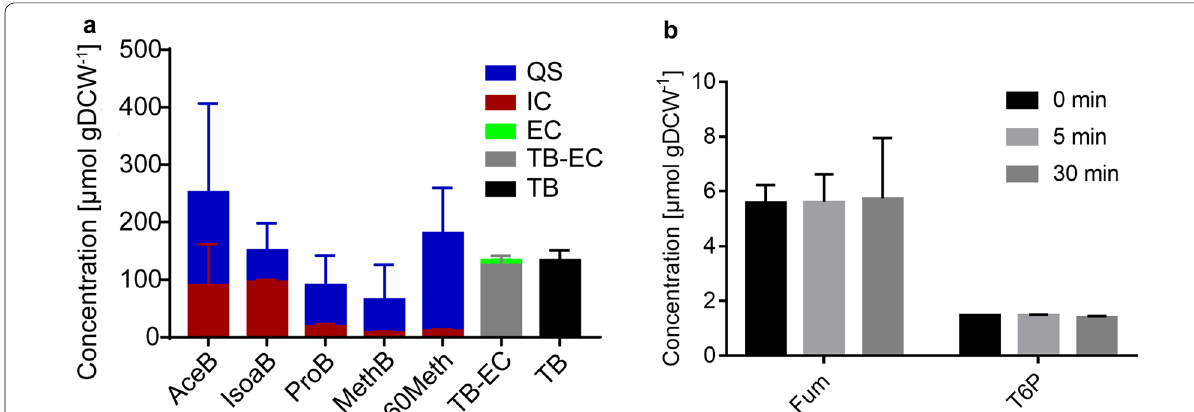
Fig. 5 a Full mass balances of all determinable metabolites. Meth60: 60% methanol at 30 °C; AceB: acetone; ProB: propanol; IsoaB: isoamylol; − MethB: methanol with base solution 5:1 (v/v) at 30 °C, respectively. The base solution consisted of acetone: ethanol 1:1 (mol/mol). QS: − = quenching supernatant; IC: intracellular; TB: total broth; and EC: extracellular. TB-EC: calculated ‘true’ intracellular metabolites. b Effect of prolonged exposure to isoamylol with base solution (5:1 v/v). Based on measured intracellular levels, fumarate (Fum) and trehalose-6-phosphate (T6P) were exemplified. The base solution consisted of acetone: ethanol 1:1 (mol/mol). Prolonged exposure was achieved by leaving samples at 30 °C 0, = − + 5, and 30 min before the centrifugation step. Samples were drawn from a culture at 60 h. Data were averages standard deviation of the three + + ± replicate samples. Each was analyzed in